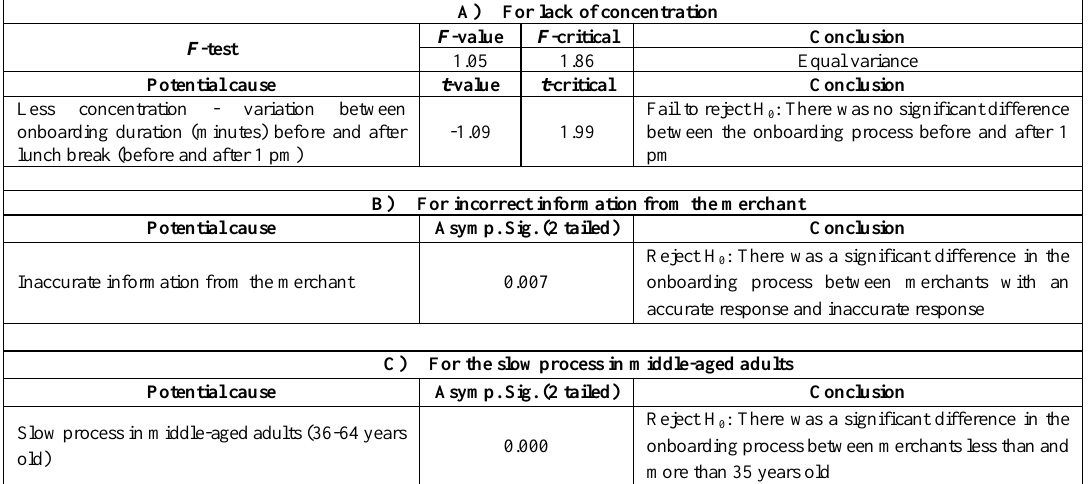
Figure 8. Probability plot for the onboarding process before 1 pm (a) and after 1 pm (b). Table 2. Hypothesis test